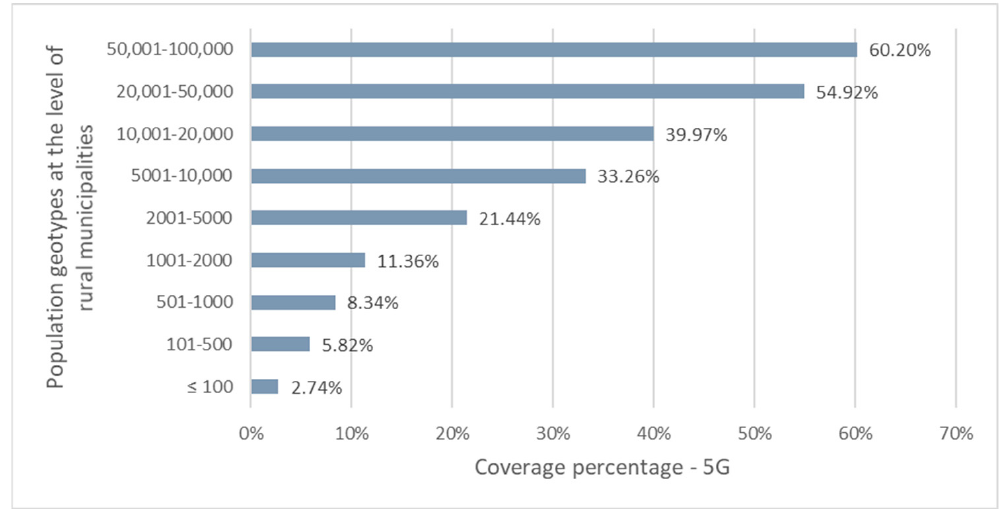
Figure 6. Aggregate 5G coverage (New Radio + Dynamic Spectrum Sharing) by population geotype (30 June 2021) [55].